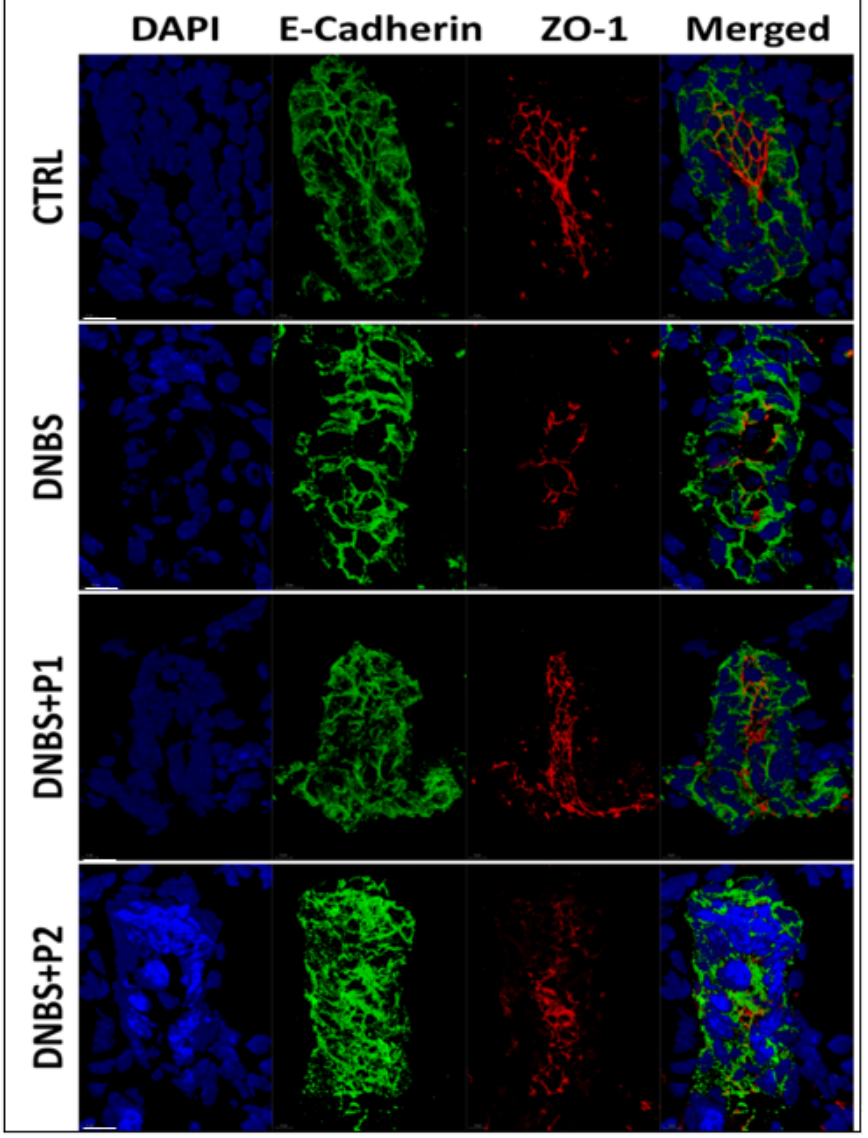
Figure 8. Impact of probiotics on DNBS-induced ZO-1 dysregulation. Colon from C57BL/6 mice was untreated (CTRL) or exposed to DNBS (1.5 mg/mL) alone or DNBS + P1 or DNBS + P2 for 5 h, in GEVS. Tissue distribution of TJs was evaluated analyzing the localization of ZO-1 (red). Epithelial cells were evidenced by the expression of E-Cadherin (green), while cell nuclei were evidenced by DAPI (blue) staining. Representative images of experiment performed in triplicate; scale bar = 10 mm.